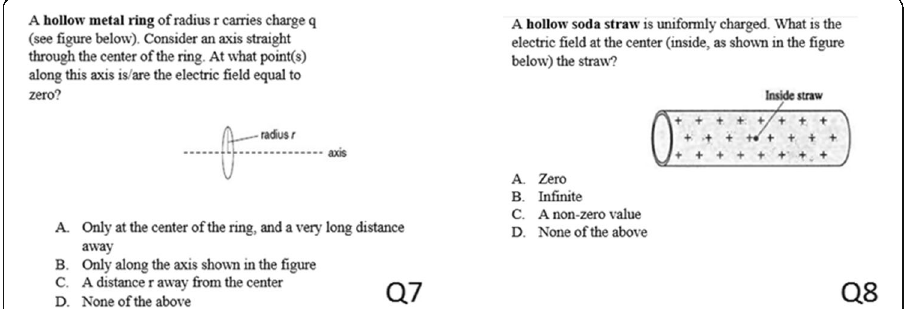
Fig. 6 Questions for ring charge configuration. Q7 Source: http://dev.physicslab.org/Document.aspx? doctype=3&filename=Electrostatics_ContinuousChargedRod.xml. Q8 Source: http://faculty.spokenfalls.edu/